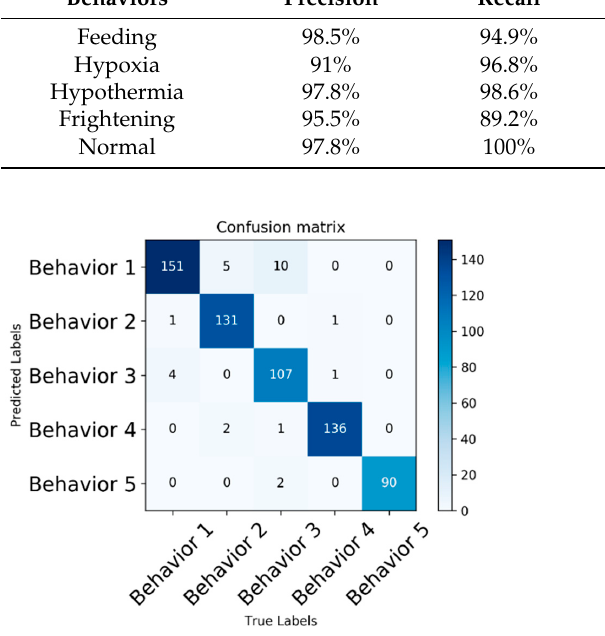
Table 3. The precision, recall, specificity, and accuracy of different behaviors of fish.